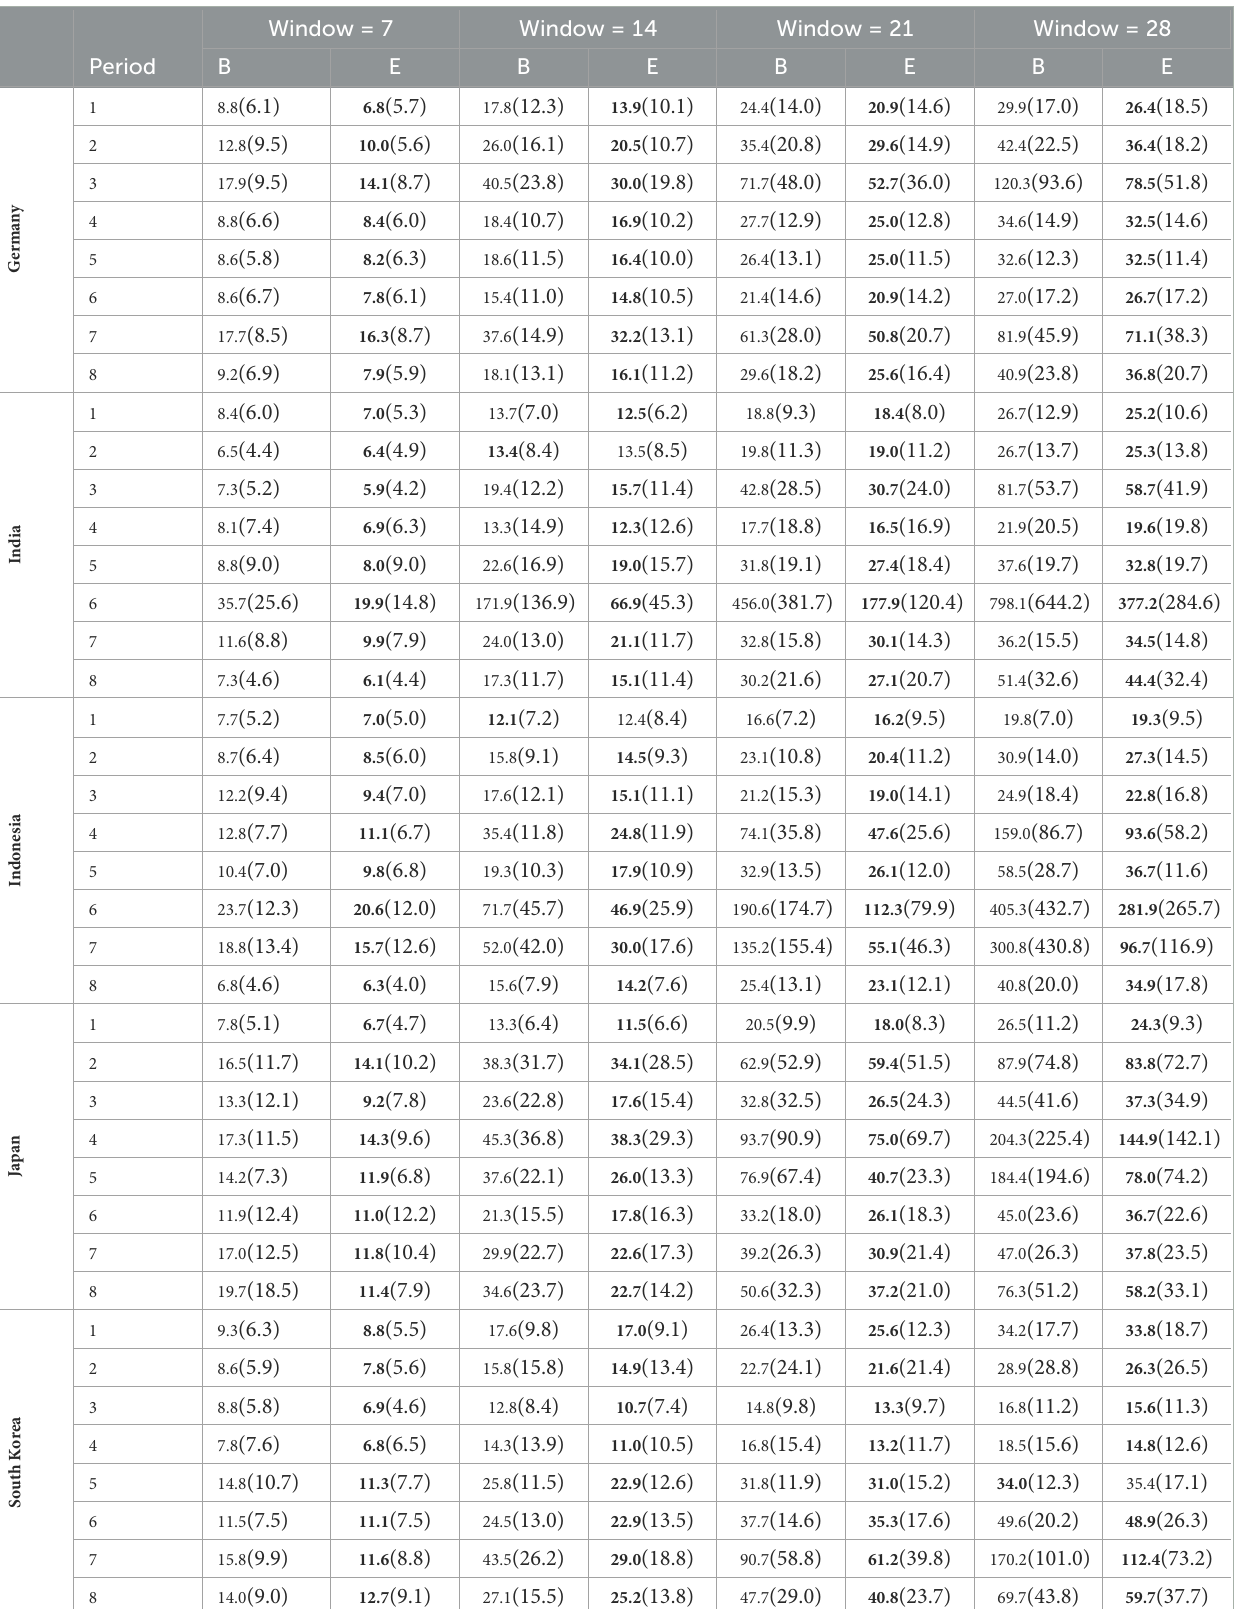
TABLE 5 Evaluation results of our system for 6 countries with the emoji features with Twitter’s “context annotation”. Window = 7 Window = 14 Window = 21 Window = 28